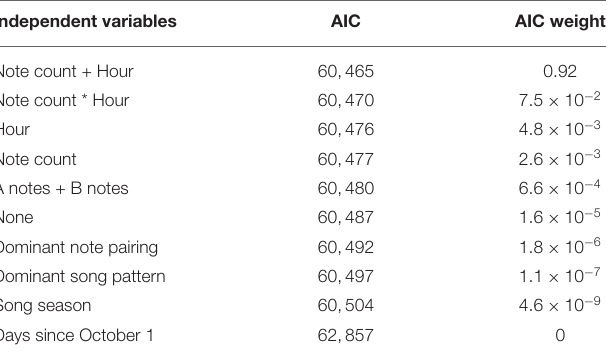
TABLE 2 | Models used to explain singing fin whale swimming behavior, ranked by the Akaike information criterion (AIC) and AIC weights (Akaike, 1974; Burnham and Anderson, 2002).